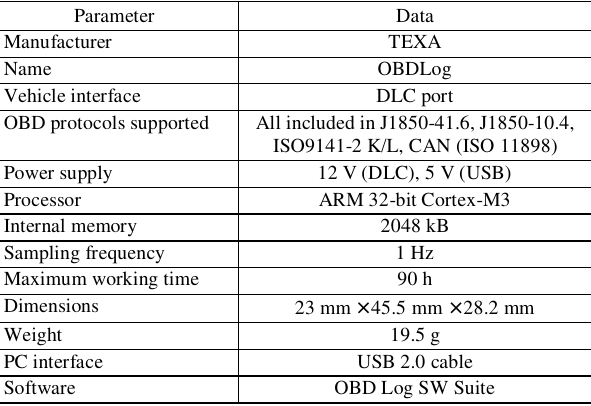
Table 2. Technical specifications of the apparatus